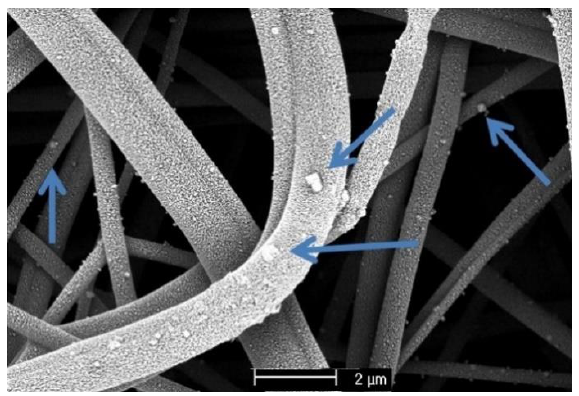
Figure 5. SEM images of the filter media PET_10% sample after filtration.